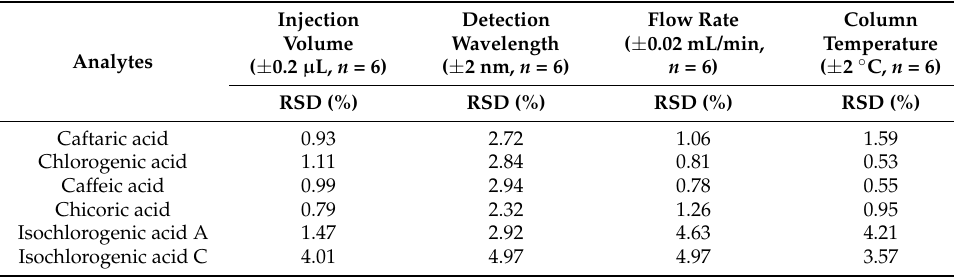
Table 10. Robustness of the quantification method validation ( n = 6).